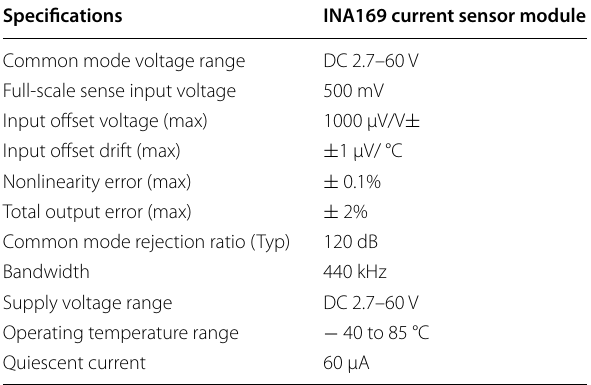
Table 4 Specifications of the INA169 current sensor mod-